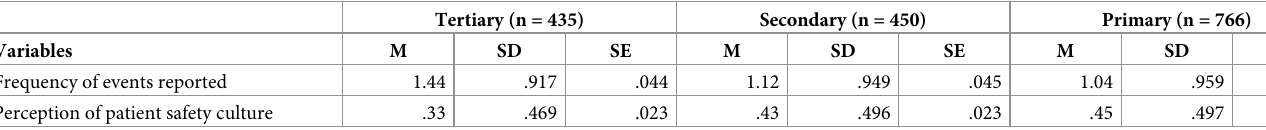
Table 3. One-way ANOVA of the frequency of reporting adverse events on three levels of